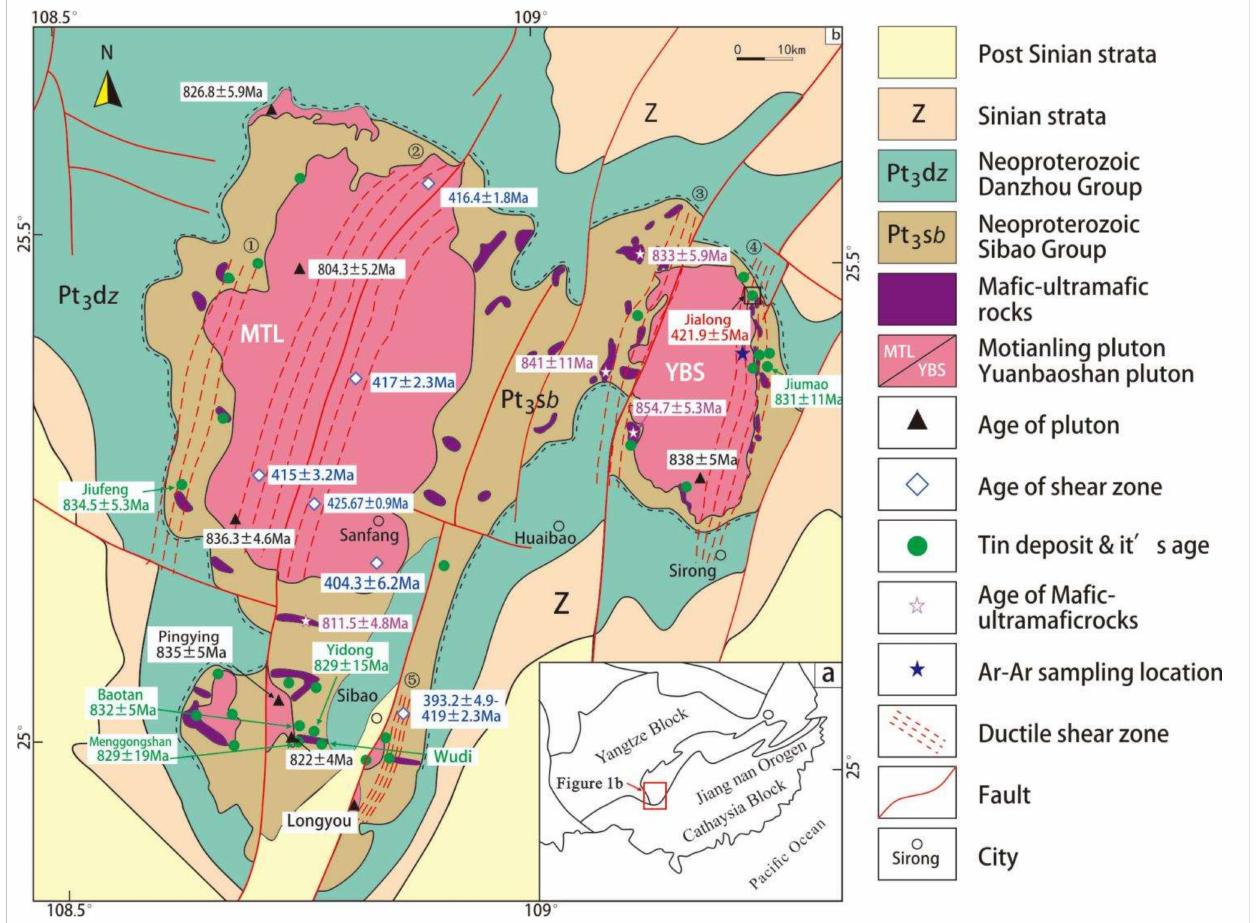
Figure 1. ( a ) Geological sketch of South China; ( b ) sketch map of the geology and distribution of Sn ore deposits in northern Guangxi [18,22,26,28–32] (modified after Mao, 1988; Wang et al., 2006; Zhang et al., 2019; Li et al., 2020, age data are referenced). Major shear zones: 1 (cid:13) Jiufeng ductile shear zone (modified after Dai et al., 2020); 2 (cid:13) Motianling ductile shear zone (modified after Zhang, 2004); 3 (cid:13) Yuanbaoshan ductile shear zone (modified after Zhang, 2004; Guo, 2017); 4 (cid:13) Sirong ductile shear zone (modified after Zhang, 2004; Guo, 2017); 5 (cid:13) Sibao ductile shear zone (modified after Zhang et al.,